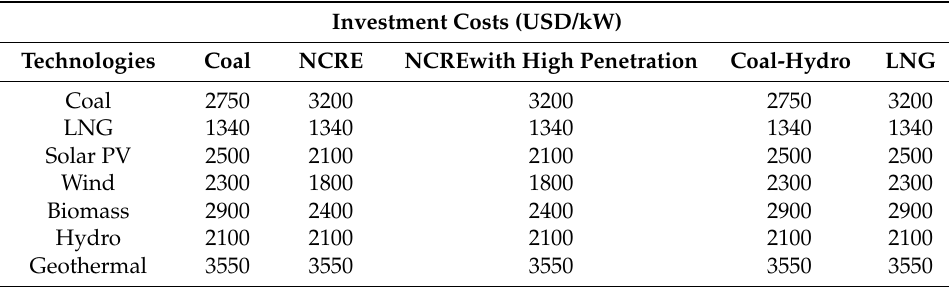
Table A1. Investment Costs per kW installed by technology for each scenario.